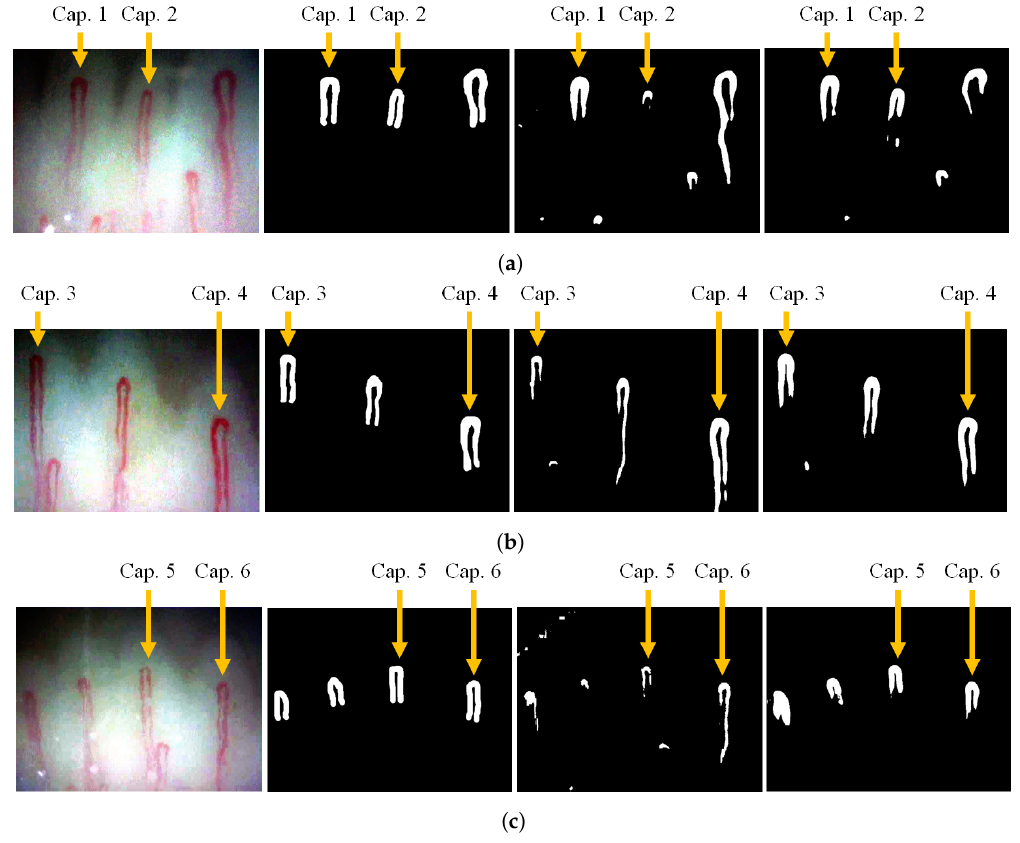
Figure 9. Capillary segmentation for videos ( a ) 1, ( b ) 2, and ( c ) 3. From left to right: the raw frame, manual segmentation, conventional segmentation, and (deep learning) semantic segmentation are displayed. The selected capillaries are indicated by the yellow